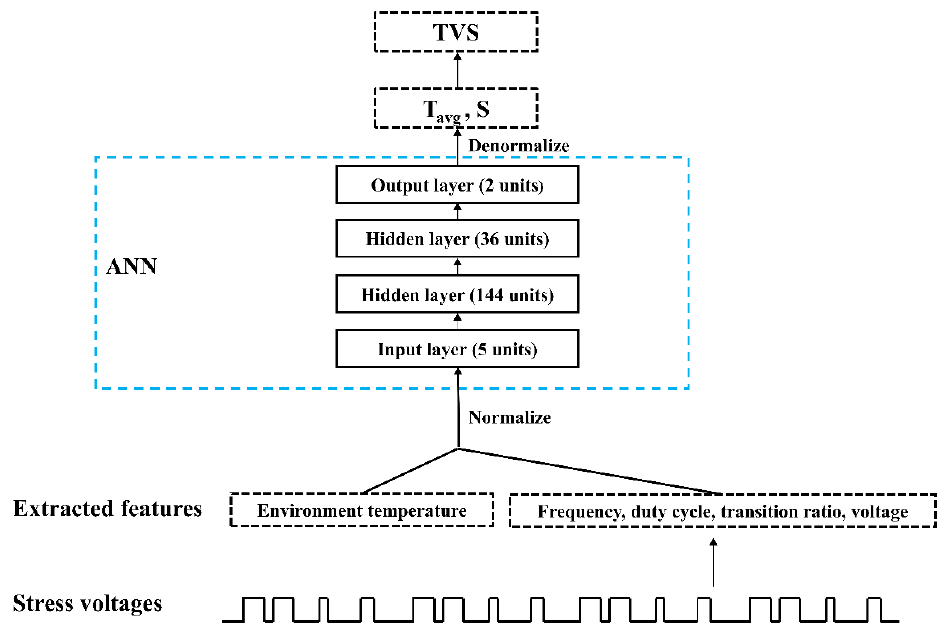
Figure 9. Diagram of the ANN model [33].